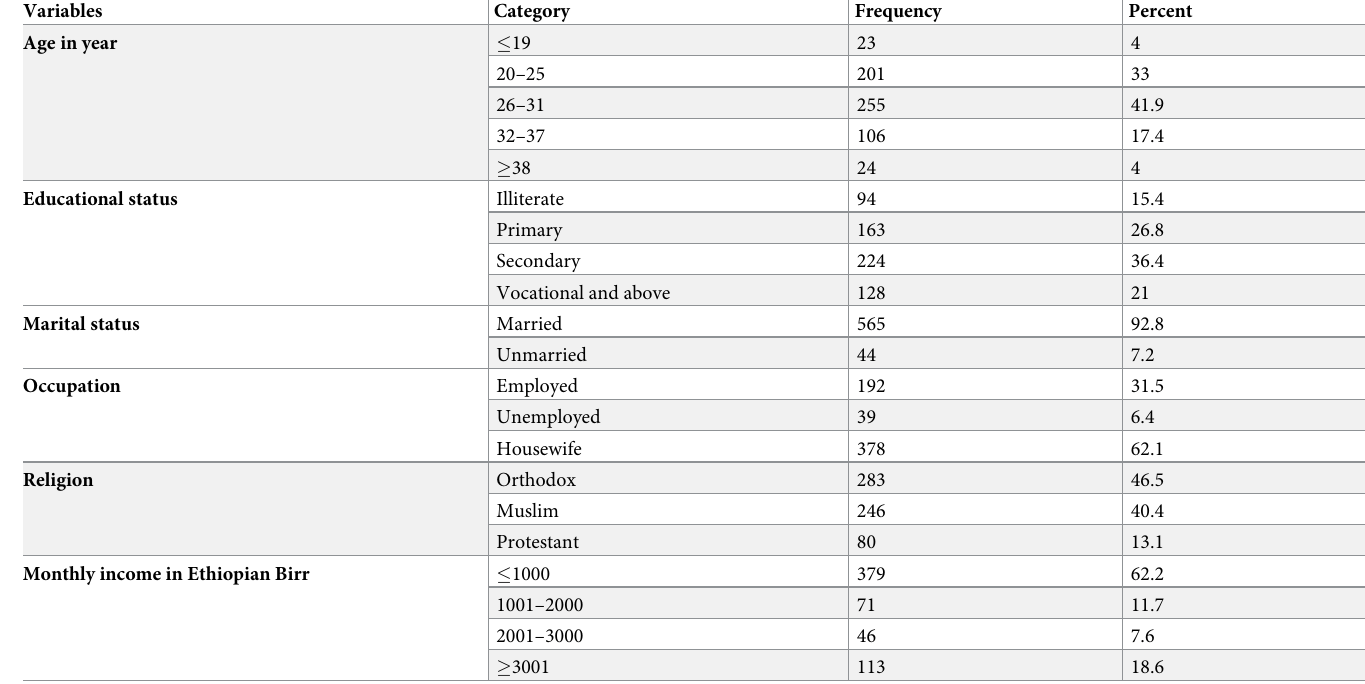
Table 1. Socio-demographic characteristics of women attending ANC services in public health centers in Addis Ababa, Ethiopia, 2020 (n = 609).